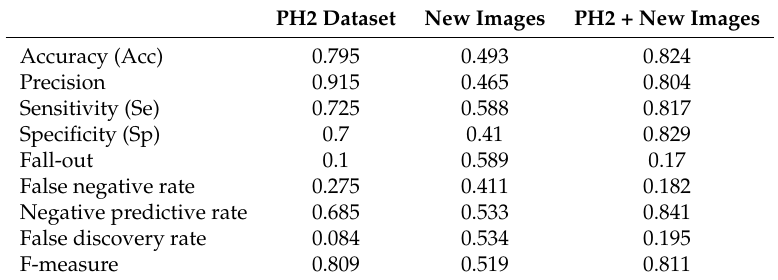
Figure 9. Selected samples used in training process—( a – c ) come from PH2 Dataset, and ( d – f ) were obtained from the method described in this paper. Table 1. Quality measures of classifier trained only for the data from PH2 Dataset, only for obtained new images from proposed method and merged both